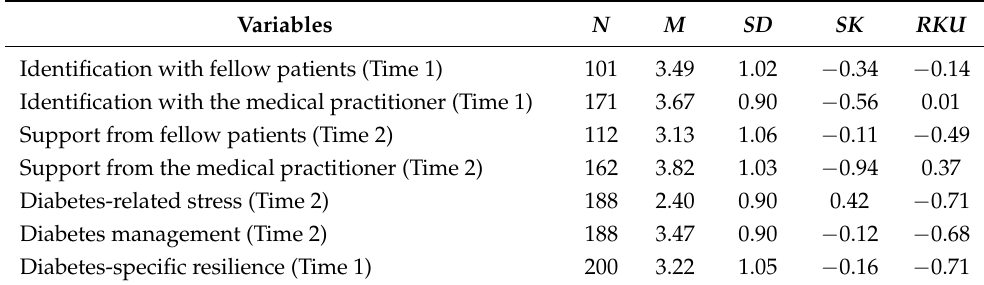
Table 2. Descriptive statistics of all study-relevant